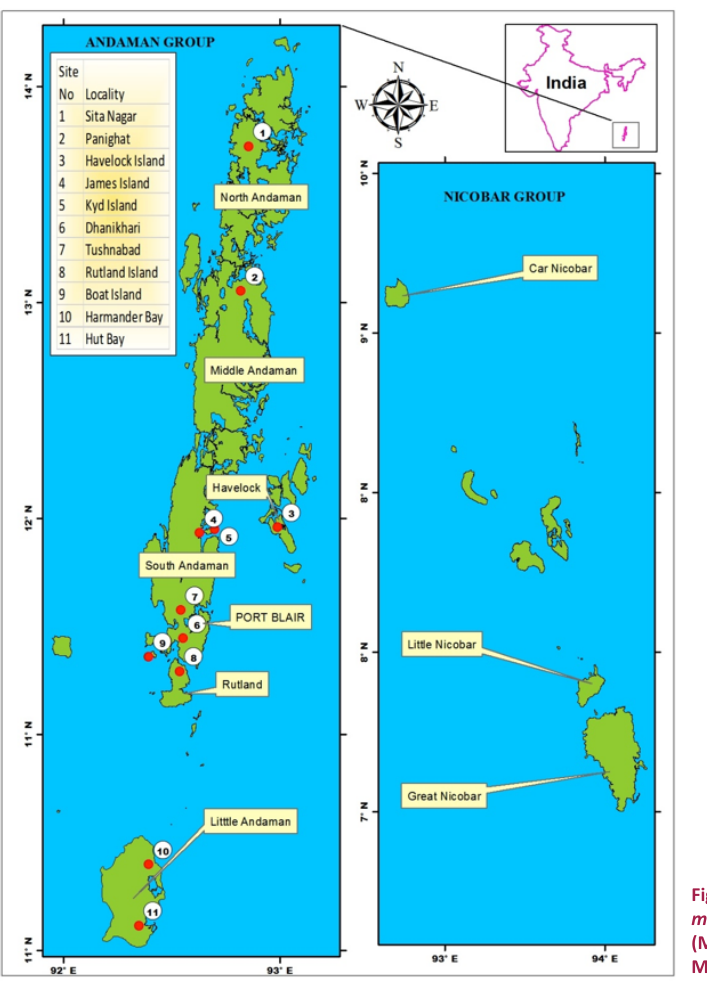
Figure 1. Map showing the distribution of Grosourdya muriculata in the Andaman & Nicobar Islands (Mapped by Dr. Shivashankar, Department of Disaster Management, Pondicherry University, Port